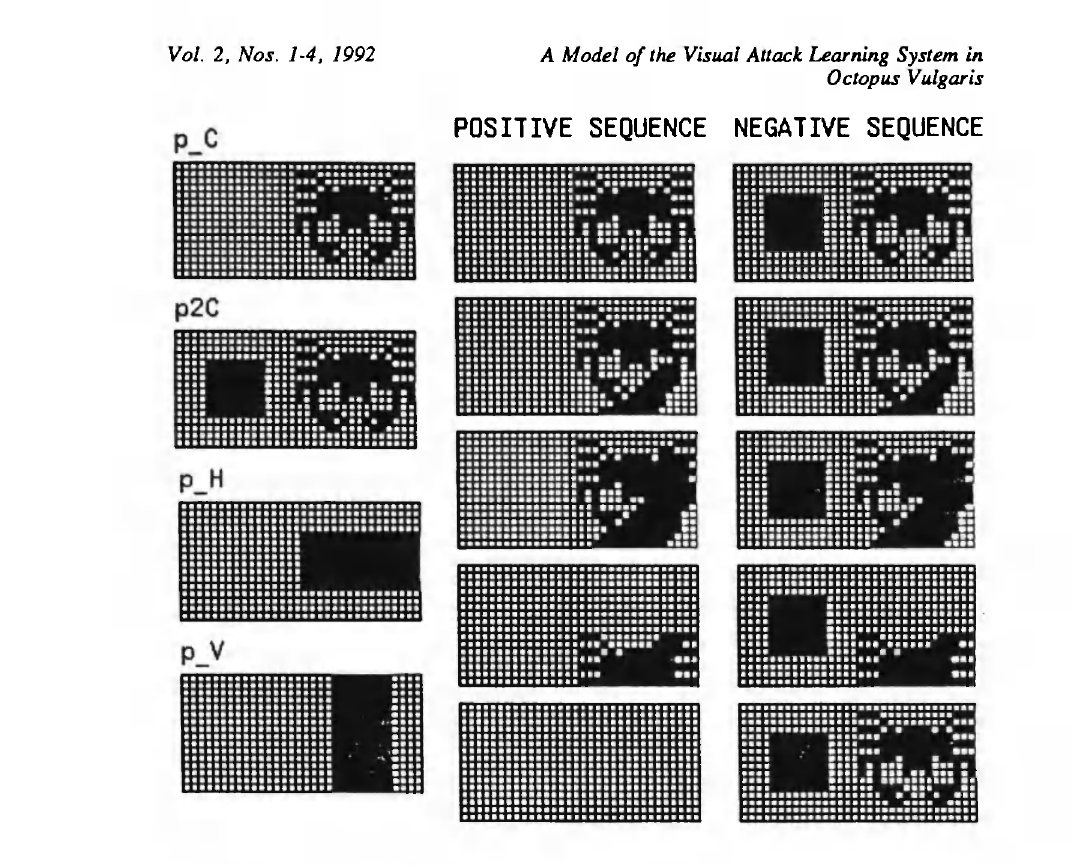
Fig. 3 Sample inputs to OVSIM. Left, from top: p-C, the crab pattern; p2C, crab with square; p-H, horizontal rectangle; p- V, vertical rectangle. Middle, from top, shows the sequence of inputs which follow attack to a positively- designated crab stimulus; positive reinforcement arrives with fifth input shown. Right, from top, shows sequence following attack to a negatively-designated crab plus square (crab is drawn down, square remains visible); on fifth cycle with negative reinforcement arriving, stimulus is released and returns to